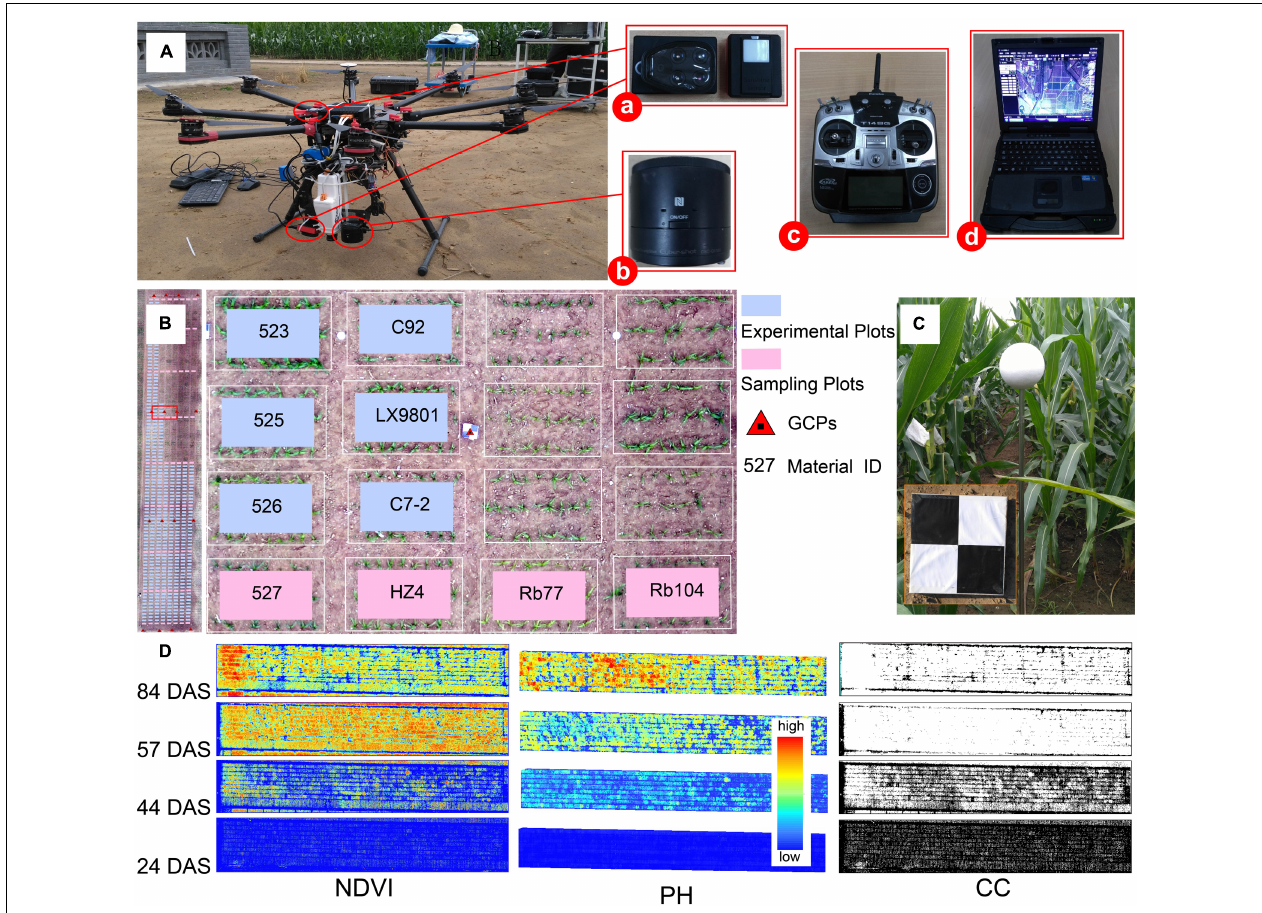
FIGURE 1 | Filed phenotype data collection and multi-temporal image processing results. (A) Components of UAV-HTPP: (a) Parrot Sequoia camera (b) Sony Cyber-shot DSC-QX100 digital camera (c) radio control system (d) ground station. (B) An overview of the experimental site (487 plots) and part of the plot details. (C) GCP markers and plant height reference ball. (D) Multi-temporal images of NDVI, PH, and CC. This indicates dynamic change in the trait difference between genotypes. CC, canopy cover; NDVI, normalized difference vegetation index; PH, plant height; DAS, days after sowing.